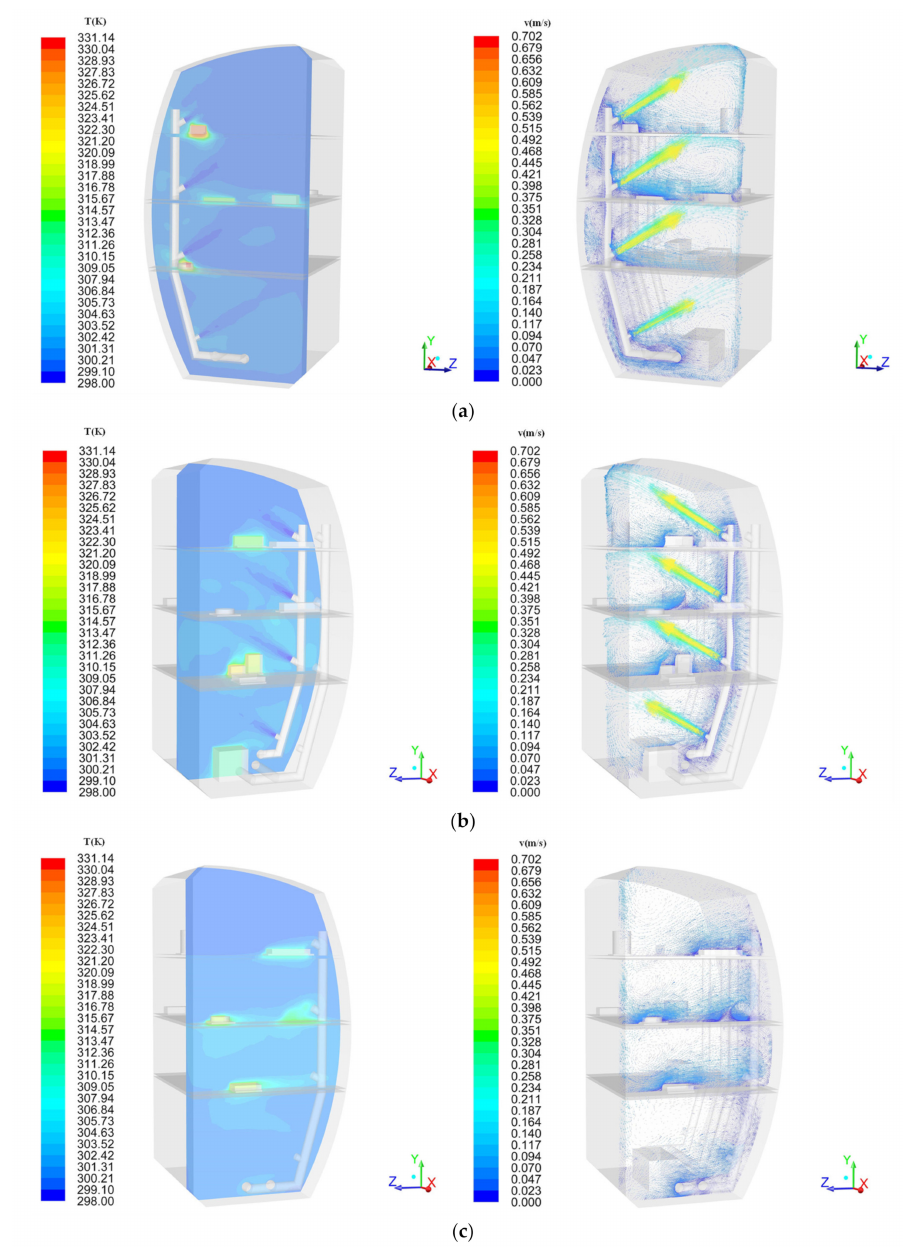
Figure 11. Temperature distribution and velocity vector of traditional 120 ◦ lower air